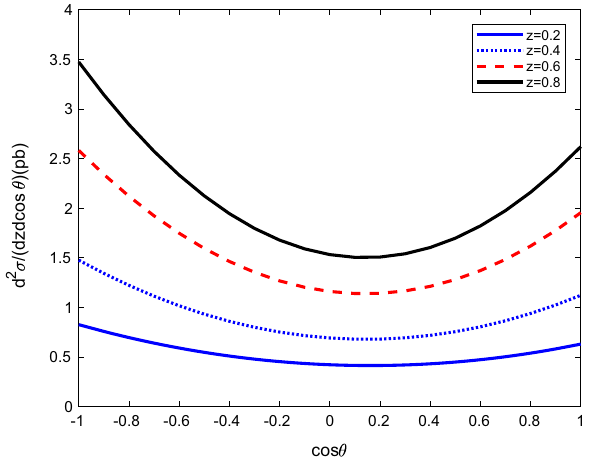
Fig. 3 The differential cross section d 2 σ/( dz d cos θ) for the produc- tion of the B c ( 2 1 S 0 ) meson at the Z pole under the fragmentation- function approach up to NLO+NLL level, where θ is the angle between the momenta of the final B c ( 2 1 S 0 ) meson and the initial electron